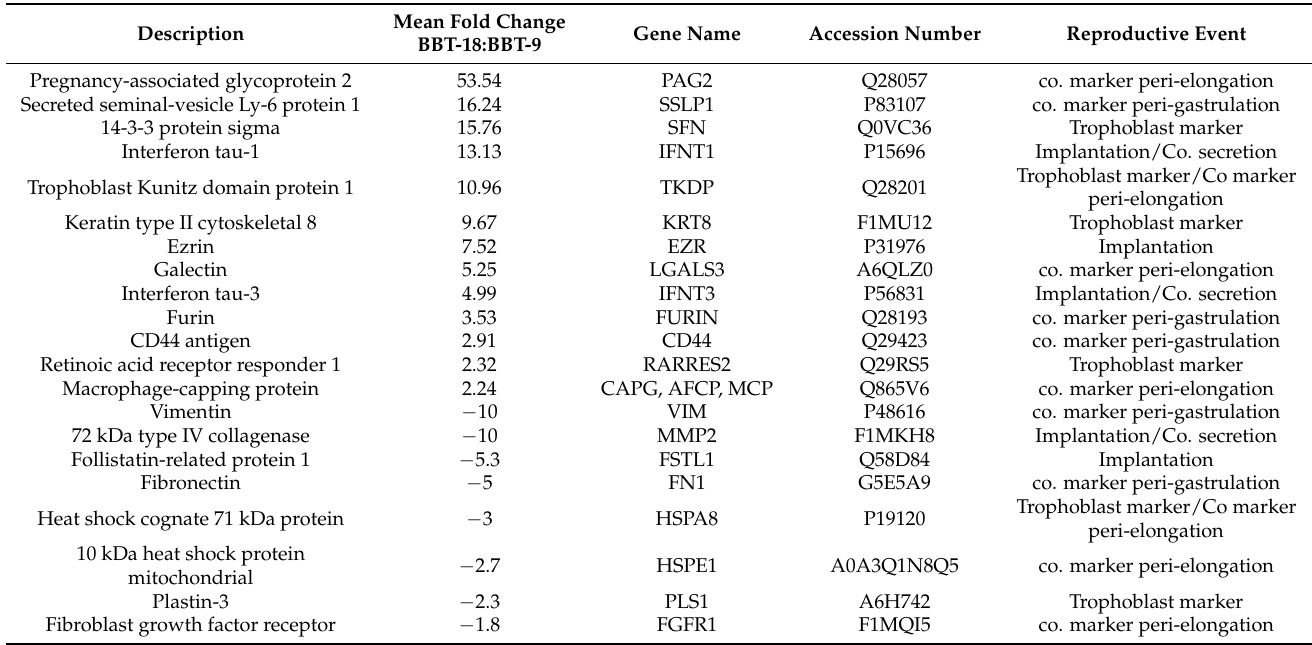
Table 3. Top early pregnancy-related proteins differentially abundant between BBT-18- and BBT-9-soluble proteins detected by iTRAQ-LC-MS/MS analysis.